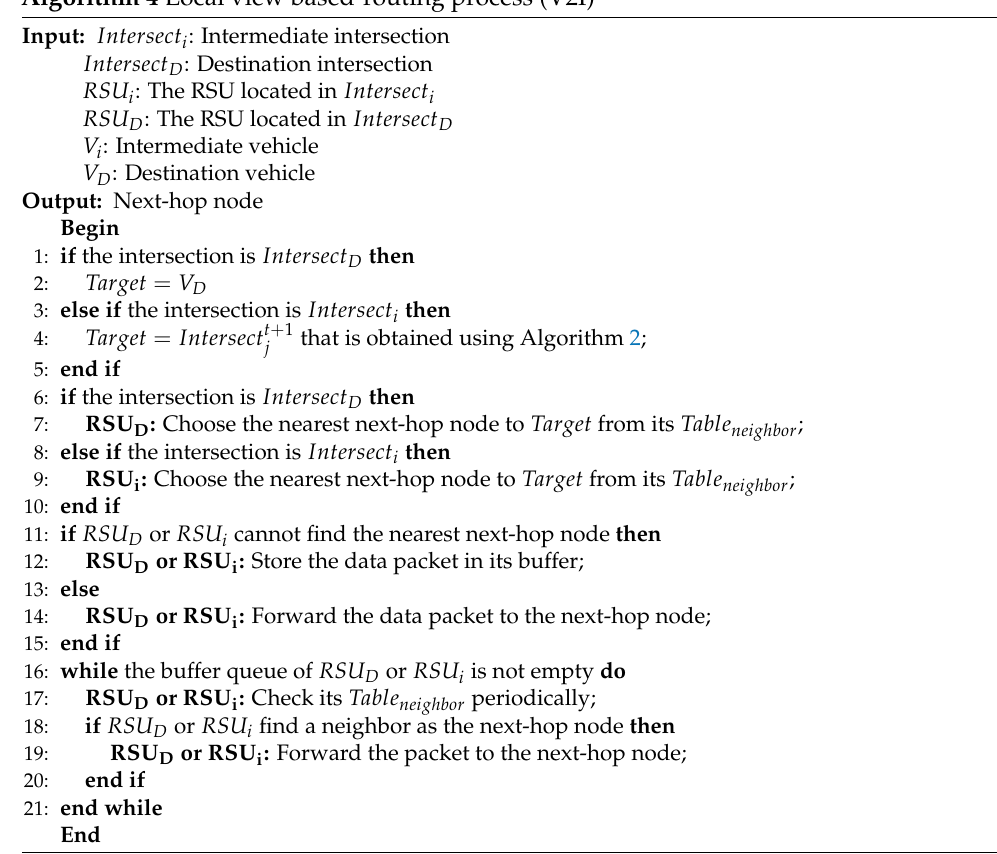
Algorithm 4 Local view based-routing process